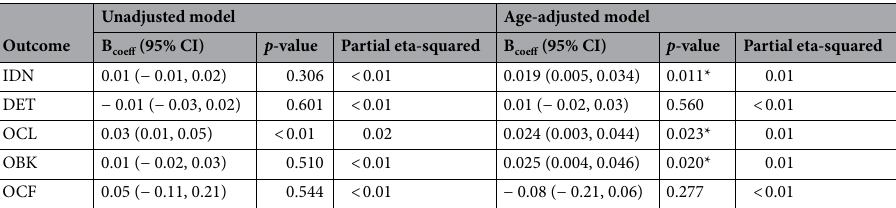
Table 3. Linear regression analyses for predicting cognitive function using APOE carrier status. IDN (identification) task measures visual identification/attention, DET (detection) task measures psychomotor function, OCL (one-card learning) task measures recognition memory/learning, OBK (one-back) task measures working memory and OCF refers to the overall cognitive function. *Significant after false discovery rate (Benjamini–Hochberg) correction.